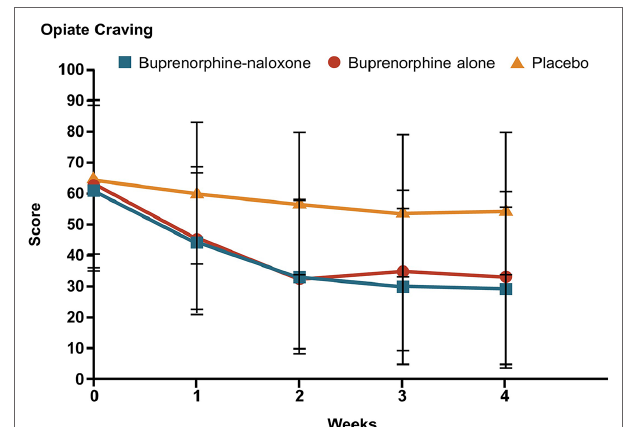
FIGURE 4 | Impact of buprenorphine on self-reported opiate craving among OUD patients (111). Patients were randomized to double- blind treatment with sublingual tablets consisting of buprenorphine (16 mg), buprenorphine-naloxone (16 mg/4 mg), or placebo given daily for 4 weeks. Self-reported opiate craving was assessed as the peak craving during the prior 24 hours measured on a 0–100 mm visual analogue scale, with higher scores representing greater craving. Statistically significant reductions in craving (p < 0.001) were reported for comparisons between buprenorphine and buprenorphine-naloxone groups versus placebo at all post-baseline time points. OUD, opioid use disorder. Reproduced with permission from the Massachusetts Medical